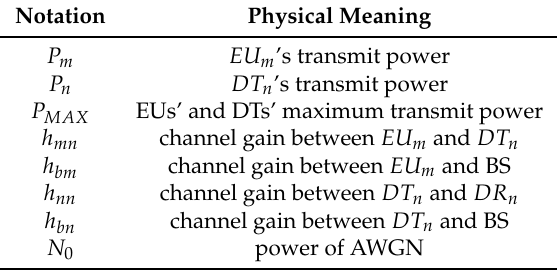
Table 1. Table of notation.